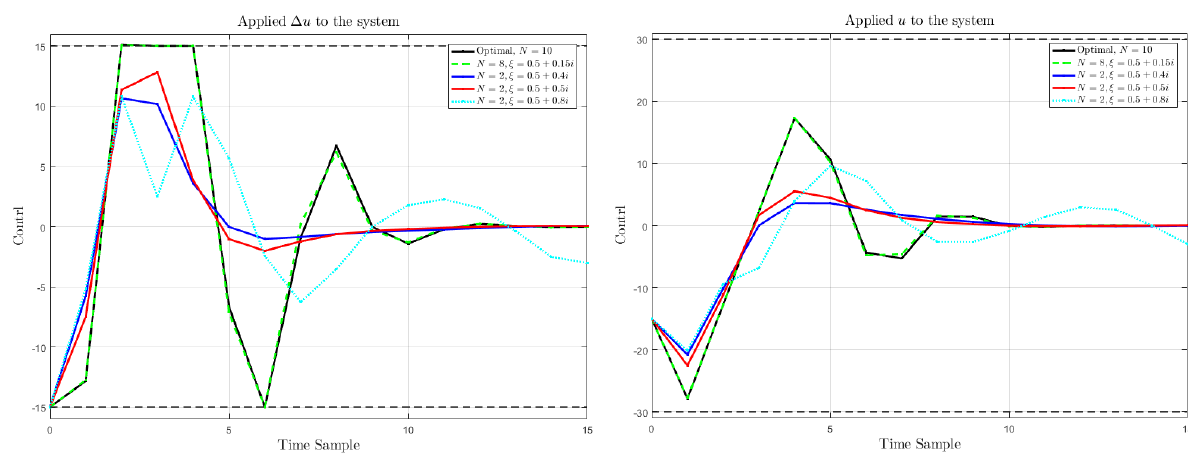
Figure 3. Applied input for different Kautz Characteristics